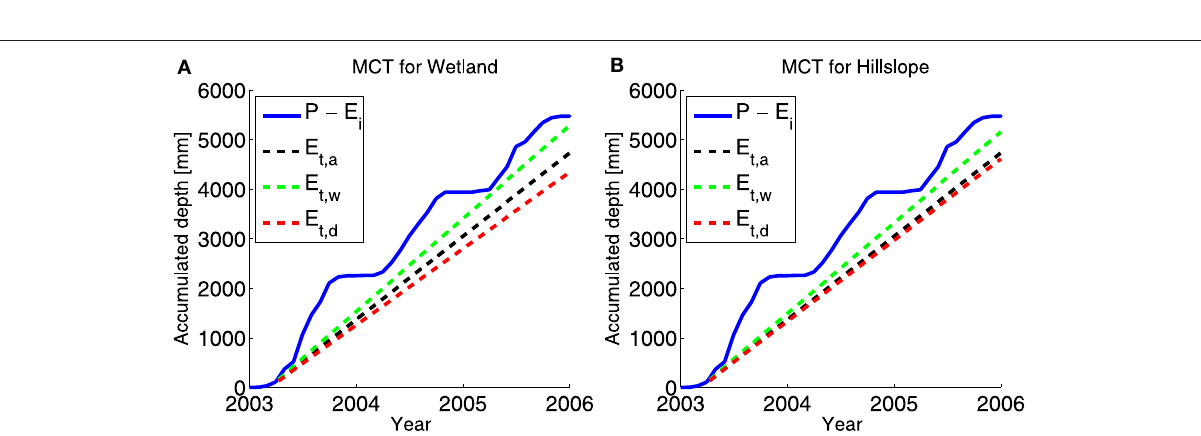
FIGURE 5 | Mass curve technique (MCT) results showing effective precipitation (precipitation P minus interception E i (blue), mean annual plant water demand E t , a (black), mean plant water demand in the wet season E w , a (green), and mean plant water demand in the dry season E d , a (red), for the (A) wetland areas, and (B) hillslope areas.